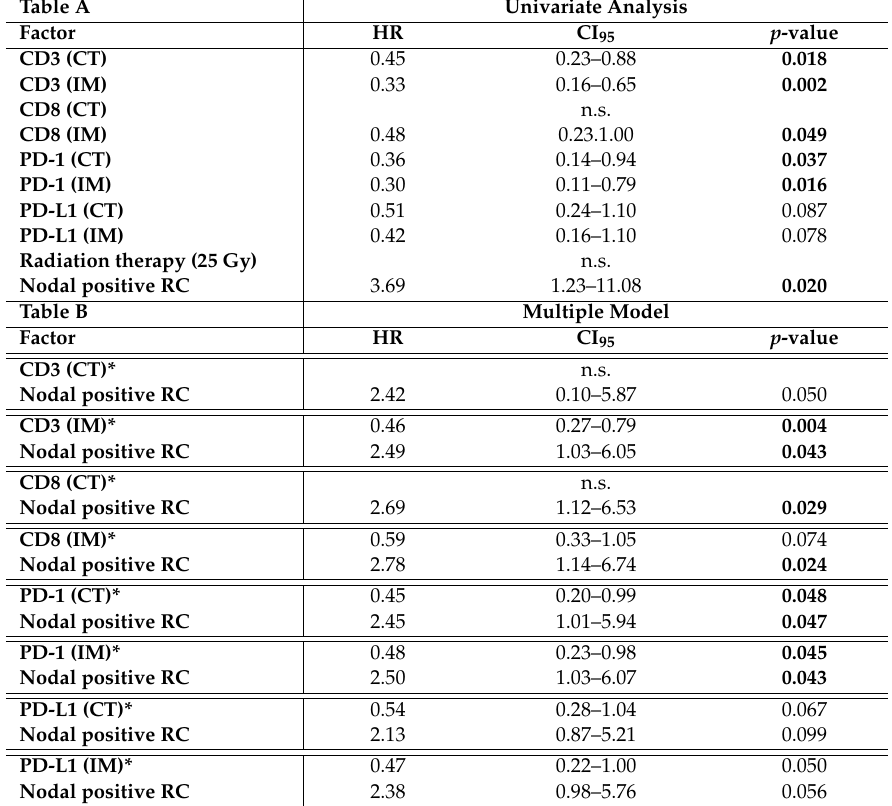
Table 5. Univariate ( A ) and multiple Cox Regression analysis ( B ) for disease-free survival of rectal cancer patients quantified using analogue quantification for T cell densities (full